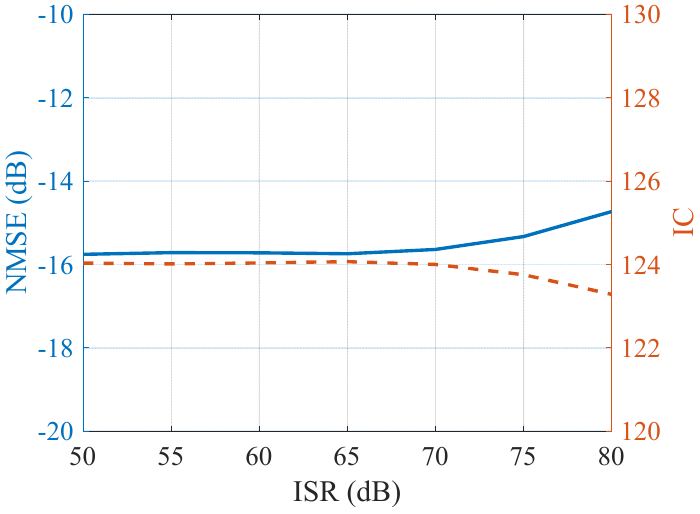
Figure 16. NMSEs and ICs of the target images obtained by TSL0 after WDR under different ISRs with random WBI parameters.